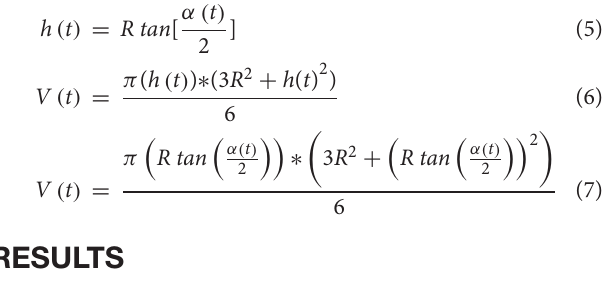
concentration c v [g mm − 3 ], and drop contact angle α